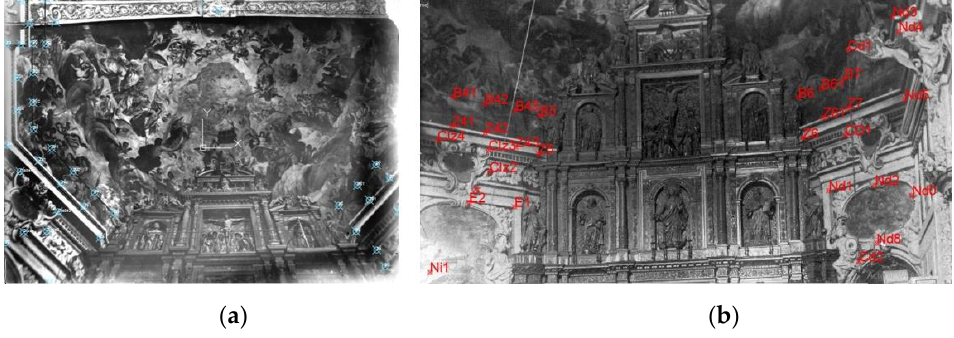
Figure 6. Selection of points. ( a ) Composition of the first image on the 3D model to identify common points (in blue). ( b ) Composition of the second image on the 3D model to identify common points (in red). Table 2. Values resulting from the coefficients (first frame).